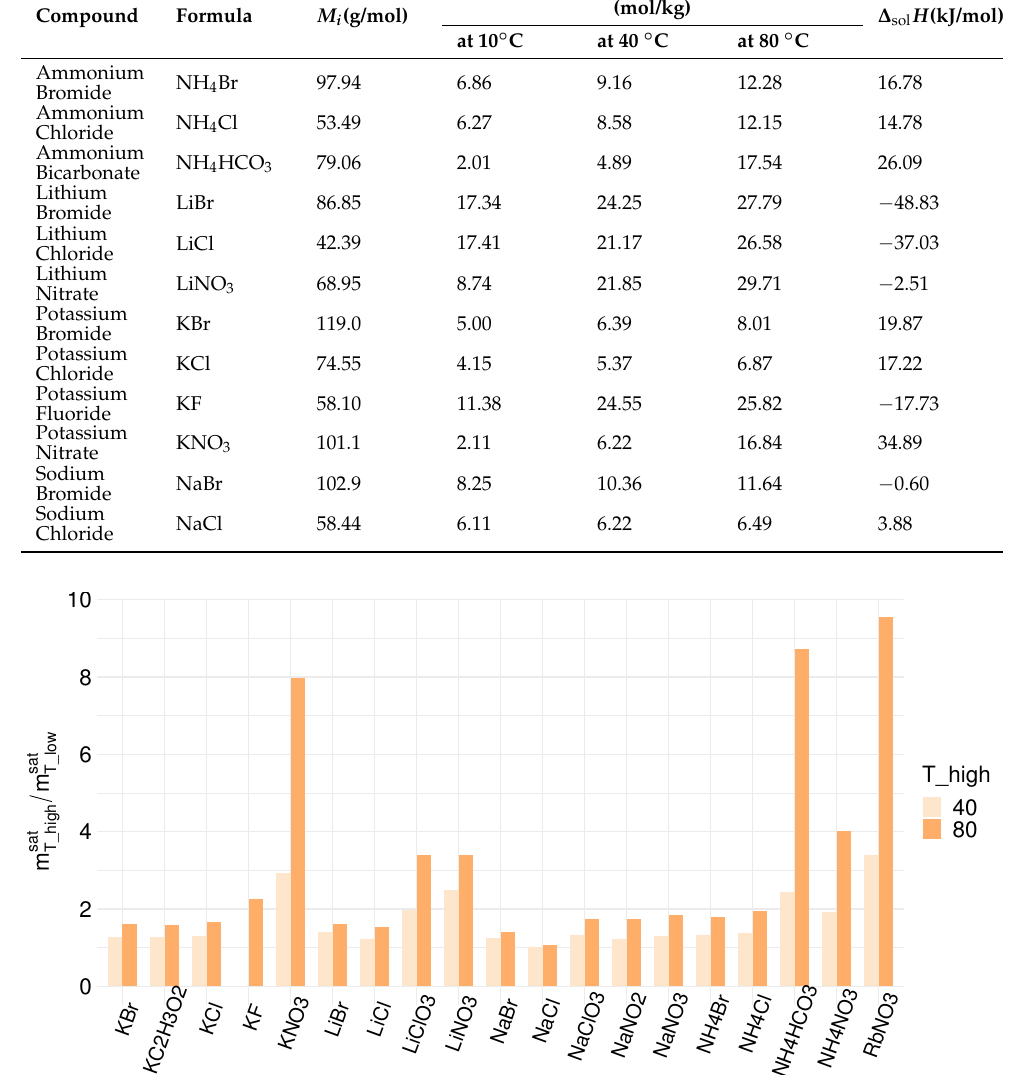
Figure 7. Saturation concentration ratio for aqueous solutions of the salts listed in Table 4 between 40 ◦ C and 10 ◦ C (light orange), and 80 ◦ C and 10 ◦ C (dark orange). Note that there was no data available for the saturation concentration of KF at 40 ◦